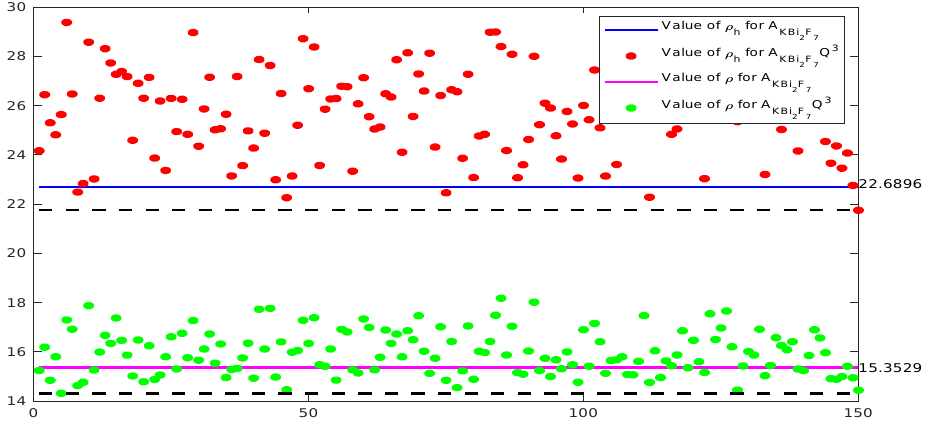
Figure 3. Comparisons among ρ and ρ Q in [12] and τ and τ Q for A KBi